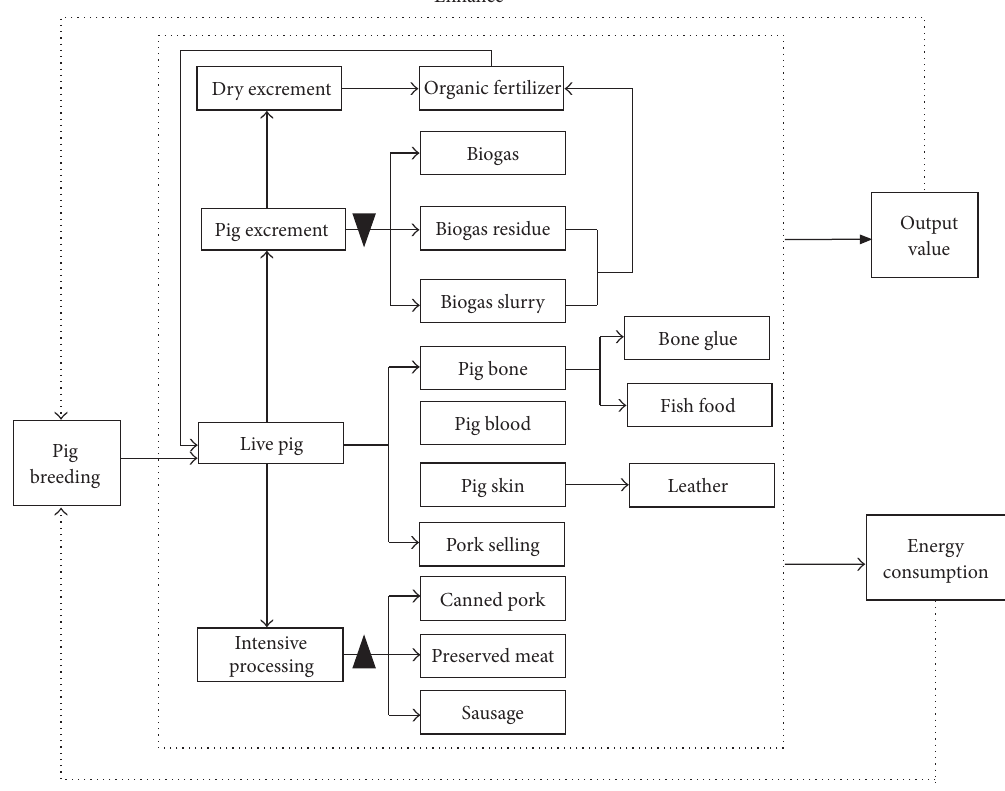
Figure 1: Pig industry